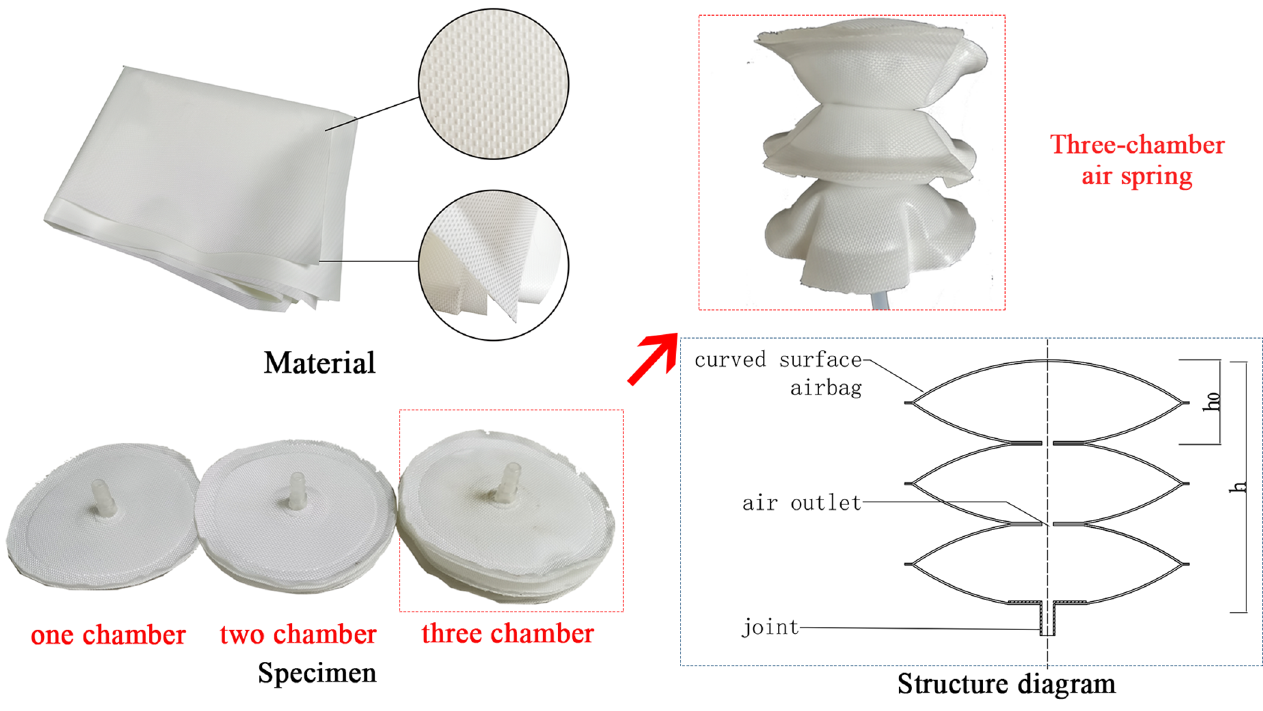
Fig. 1. Material and air spring. Table 2. Working information of equipment and instruments.